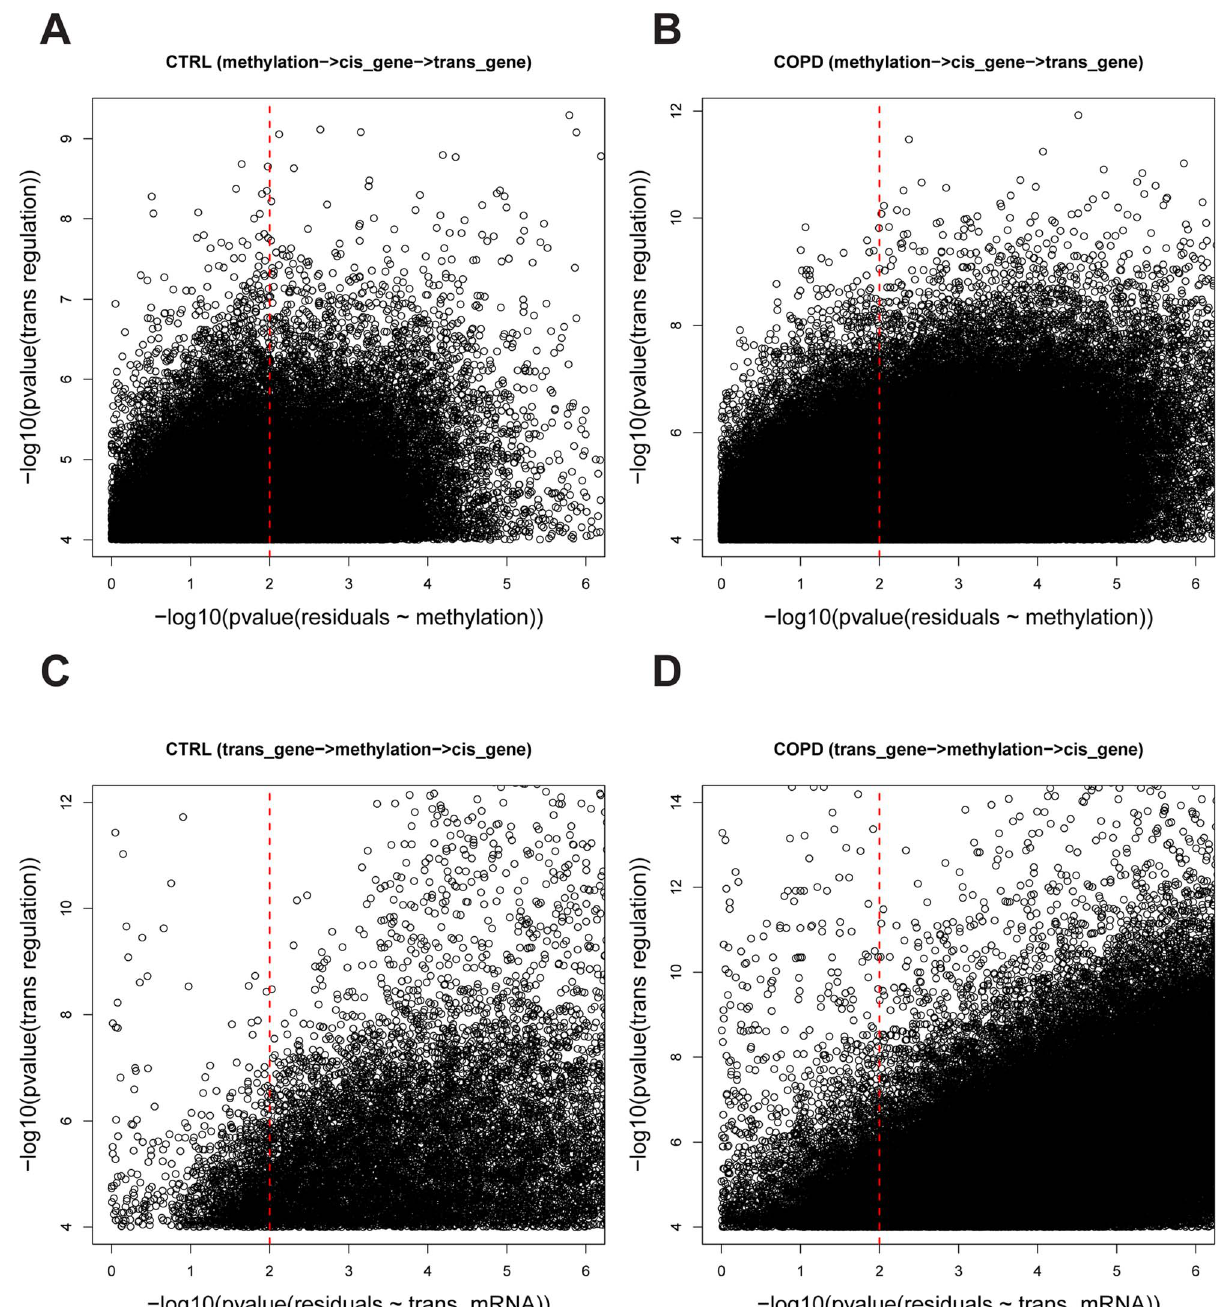
Fig. 2. The causality test of trans methyl-mRNA pairs. A ) and B ) are causality test results for the causal model whereby methylation regulates trans gene expression (methylation m j R cis gene expression g j R trans gene expression g i ) in control and COPD data sets, respectively. The Y-axis is the –log10 of the p-values for the Spearman correlation between m j and g i and the X-axis is –log10 of the p-values for the Spearman correlation between m j and g i D g j . A causal relationship (methylation m j R cis gene expression g j R trans gene expression g i ) was defined if the p-value of corr ( m j , g i ) was , 0.0001 and the p-value of corr ( m j , g i D g j ) was . 0.01 (see Methods for details). A total of 30,177 and 362,095 causal pairs were inferred in control and COPD samples, respectively. C ) and D ) are the causality test results for the causal model whereby trans gene expression regulates methylation variation ( trans gene expression g j R methylation m i R cis gene expression g i ) in control and COPD data sets, respectively. The Y-axis is the –log10 of the p-values for the Spearman correlation corr ( g i , g j ) and the X-axis is –log10 of the p-values for the Spearman correlation corr ( g j , g i D m j ) . A causal relationship ( trans gene expression g j R methylation m i R cis gene expression g i ) was defined if the p-value of corr ( g i , g j ) was , 0.0001 and the p- value of corr ( g j , g i D m j ) was . 0.01 (see Methods for details). A total of 1,241 and 19,173 causal pairs were inferred in control and COPD, respectively.